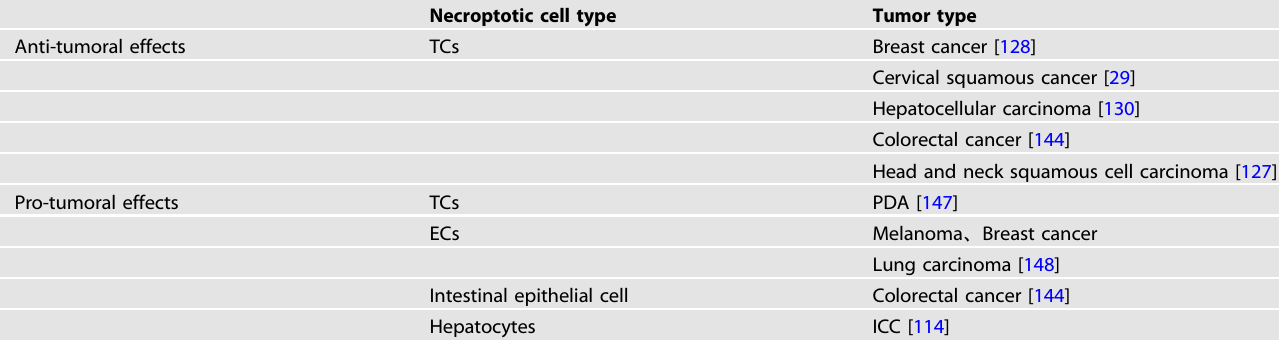
Table 2. The pro- and anti-tumoral effects of necroptosis in tumors.